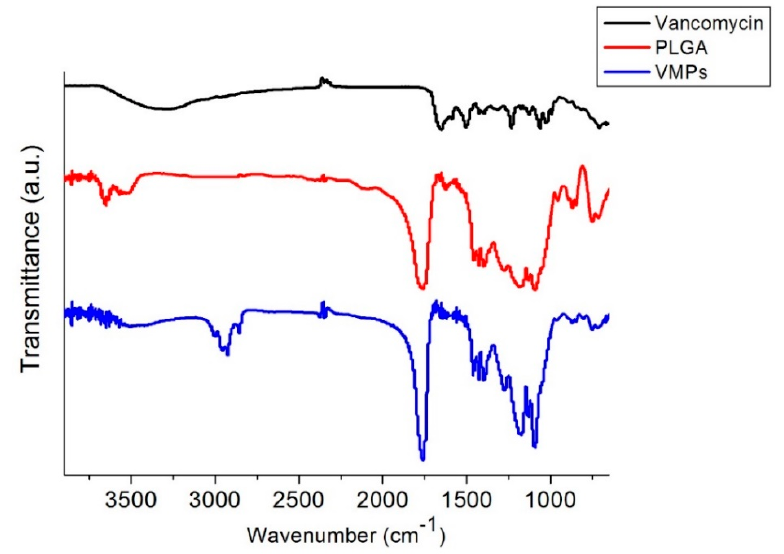
Figure 3. Fourier-transform spectra of the pharmaceuticals, pure poly(lactic- co -glycolide acid) (PLGA), and VMPs.